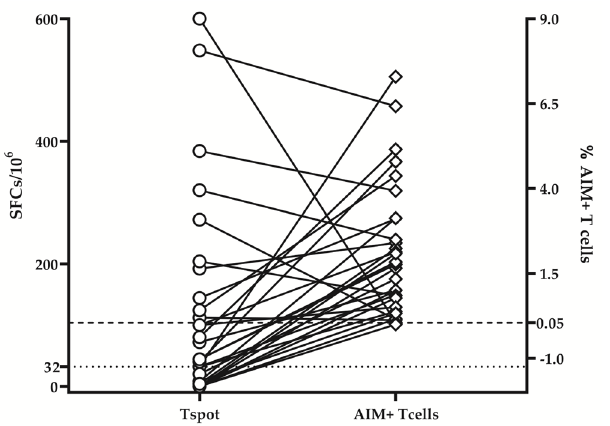
Figure 4. ELISpot and flow cytometry results regarding memory T-cell responses. Comparison between the share of virus-specific memory T cells determined by ELISpot and by flow cytometry detection of AIM+ T cells (paired data). Both samples acquired before and beyond 9 months post-infection are included. The dotted and dashed lines correspond to the cut-off levels of ELISpot (32 SFCs/10 6 PMBCs) and flow cytometry AIM test, respectively.